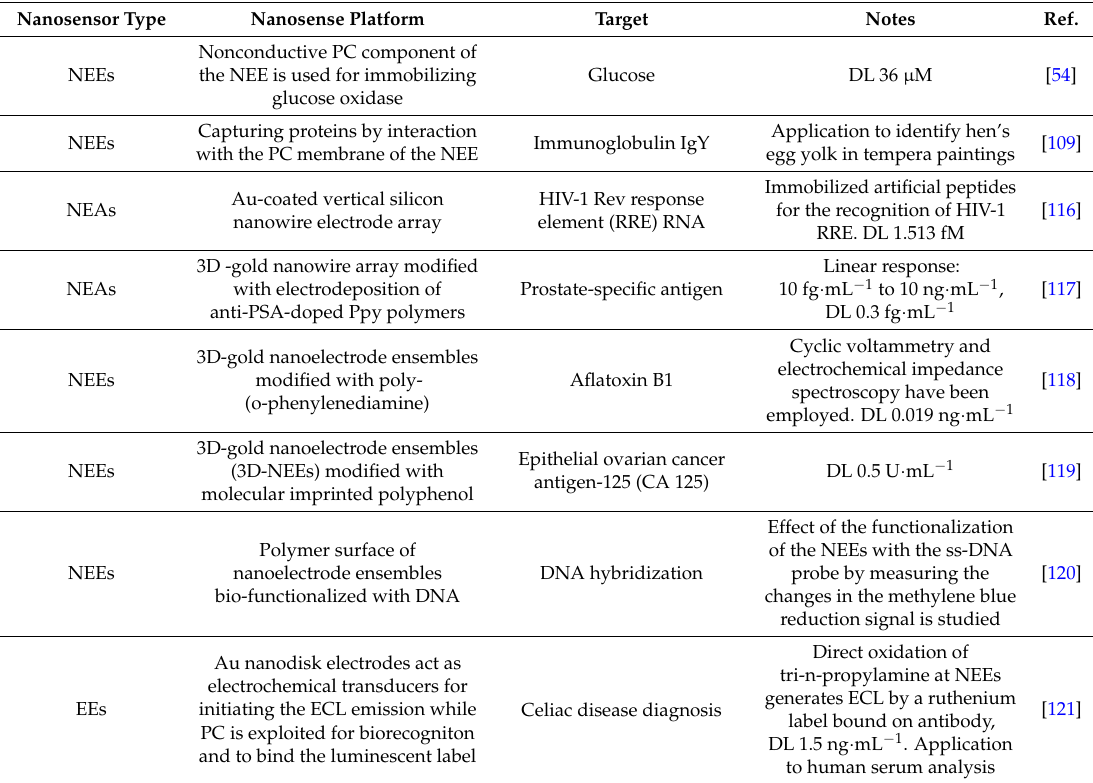
Table 2. Articles published in the years 2012–2016, dealing with the application of NEEs/NEAs for the development of electrochemical sensors for biomacromolecules.